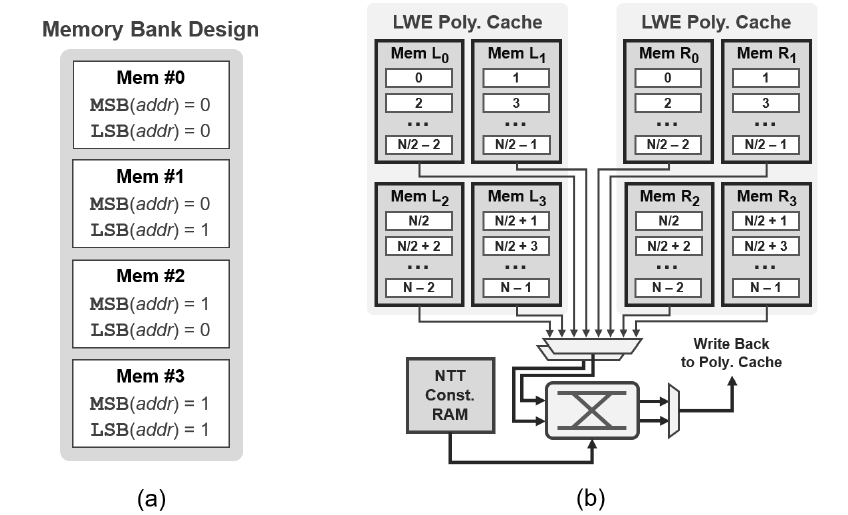
Figure 5: (a) Memory bank construction using single-port SRAMs and (b) proposed area-efficient NTT architecture using two such memory banks.